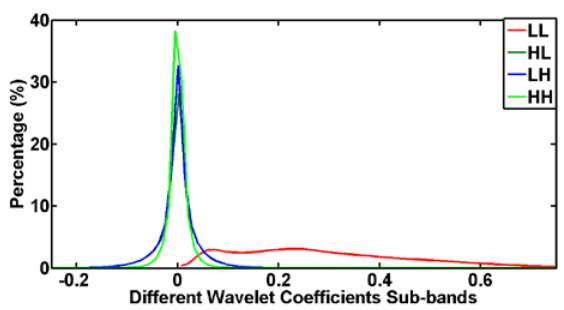
Figure 4. The histograms of different wavelet sub-bands of one-level WPT applied to each band of Pavia University , LL is the low-frequency sub-band, HL, LH, and HH are high-frequency sub-bands.